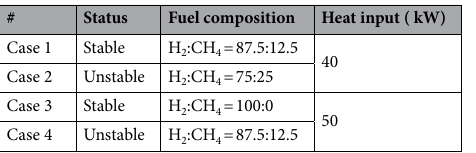
Table 6. Case study data